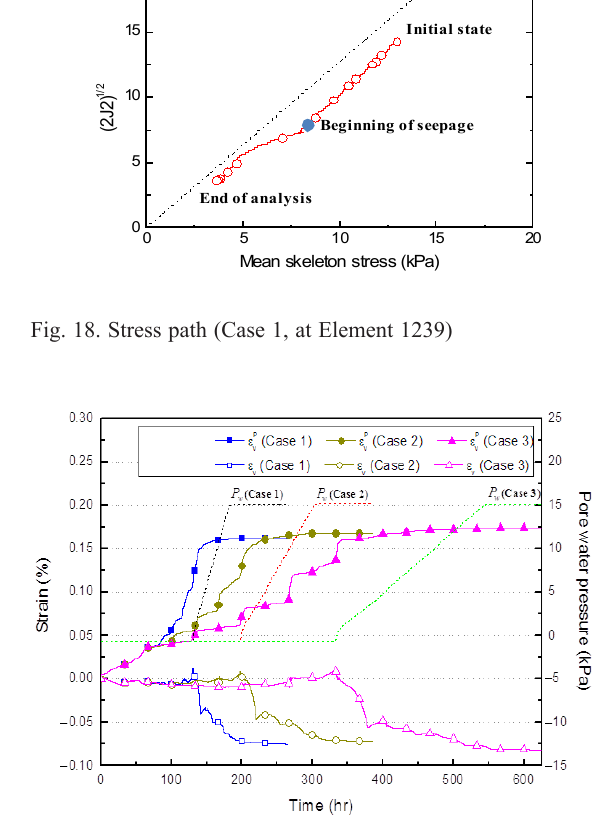
Fig. 19. Time histories of pore water pressure, plastic volumetric strain and volumetric strain on each case (at Element 1239)